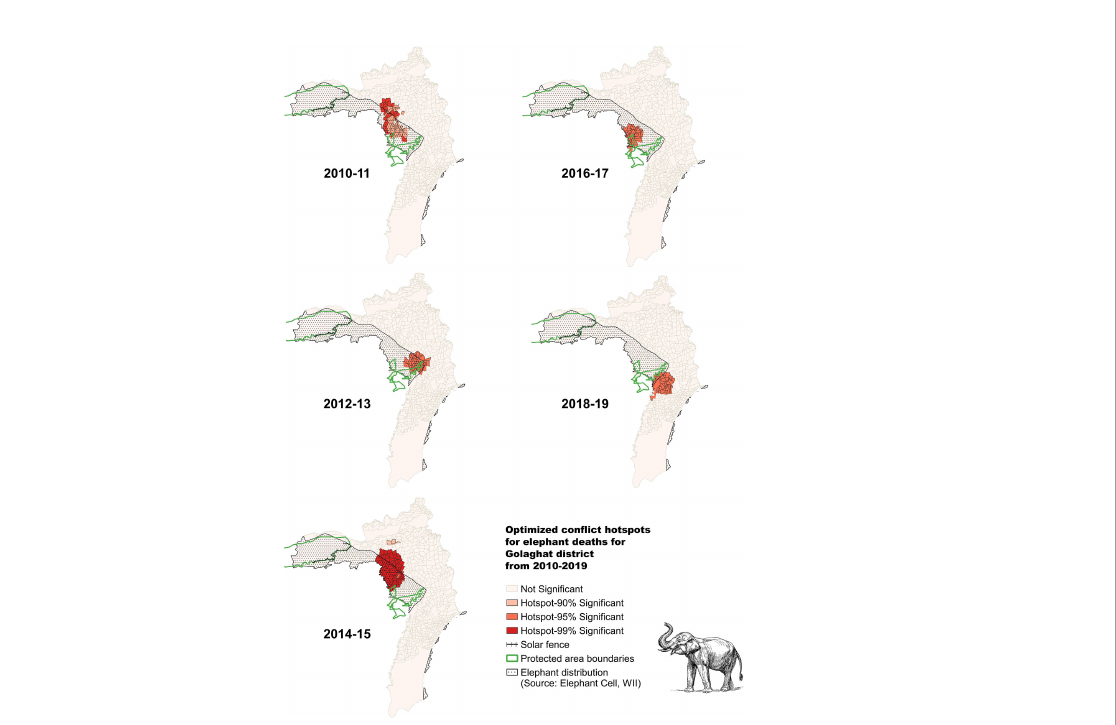
FIGURE 5 Con fl ict distribution and dispersion over the time period between 2010 and 2019 in the form of optimized elephant death hotspots for Golaghat district.